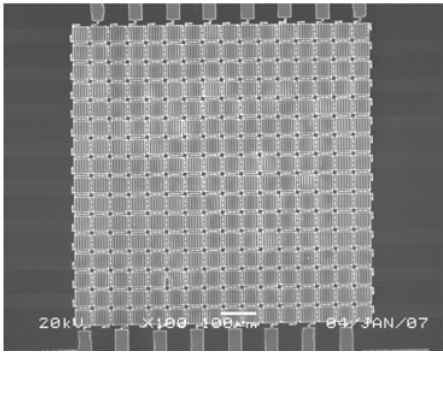
Figure 4. A SEM photograph of passive matrix addressing for the 16×16 GLM array.